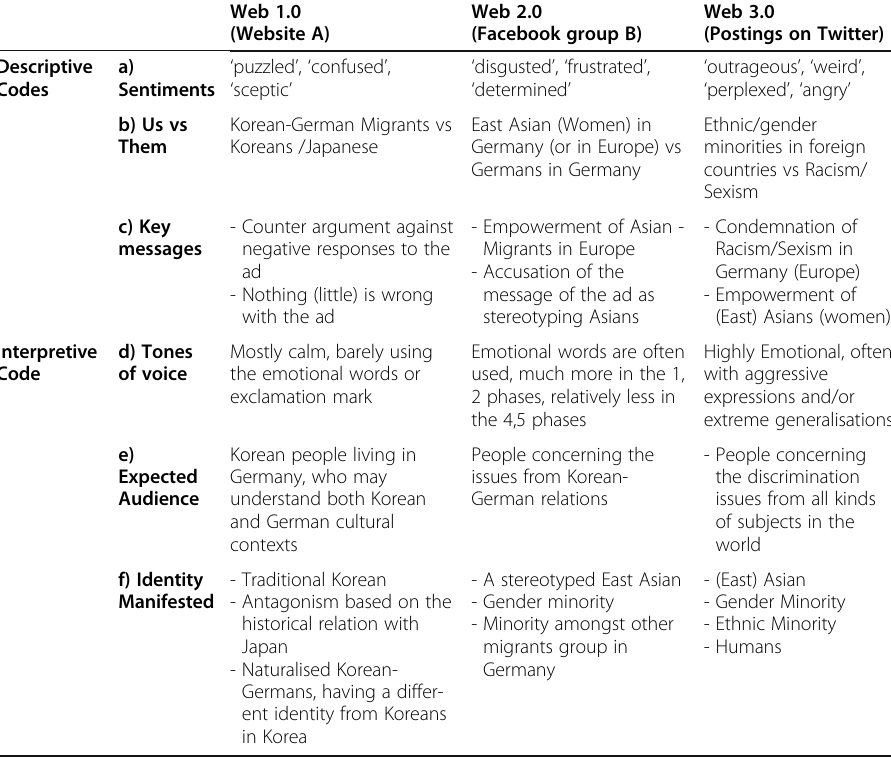
Table 3 Comparative Analysis on Three Online Social